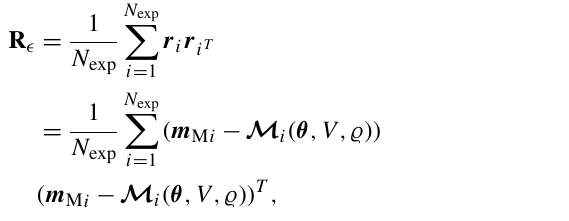
Figure 7. Wind state observed with the nonlinear model for different steady inflow conditions at 5ms − 1 : yaw misalignment φ at χ κ h 0 . 1 (a) , vertical shear κ v at χ = − and φ 8 ◦ (d) = −